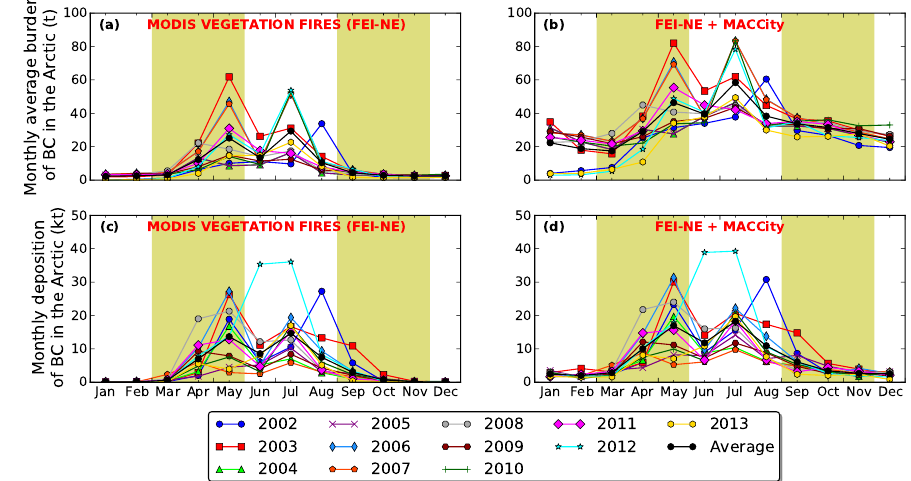
Figure 4. Monthly atmospheric burden of BC (t) in the Arctic with each year between 2002 and 2013 represented by a different coloured line: (a) from vegetation fires (FEI-NE) only and (b) from all BC emissions (FEI-NE + MACCity). Panels (c) and (d) show the same, but for the Arctic deposition of BC